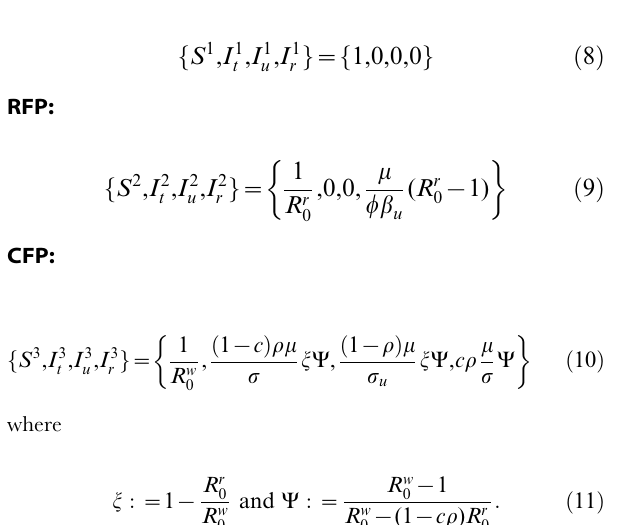
Figure 2. Stability regions in the ( r , w ) and ( R w space. Coexistence 2FP (CFP stable, DFE unstable); Coexistence 3FP (CFP stable, DFE unstable, RFP unstable); Resistance (DFE unstable, RFP stable). When the system crosses any of the region boundaries it experiences a transcritical bifurcation.